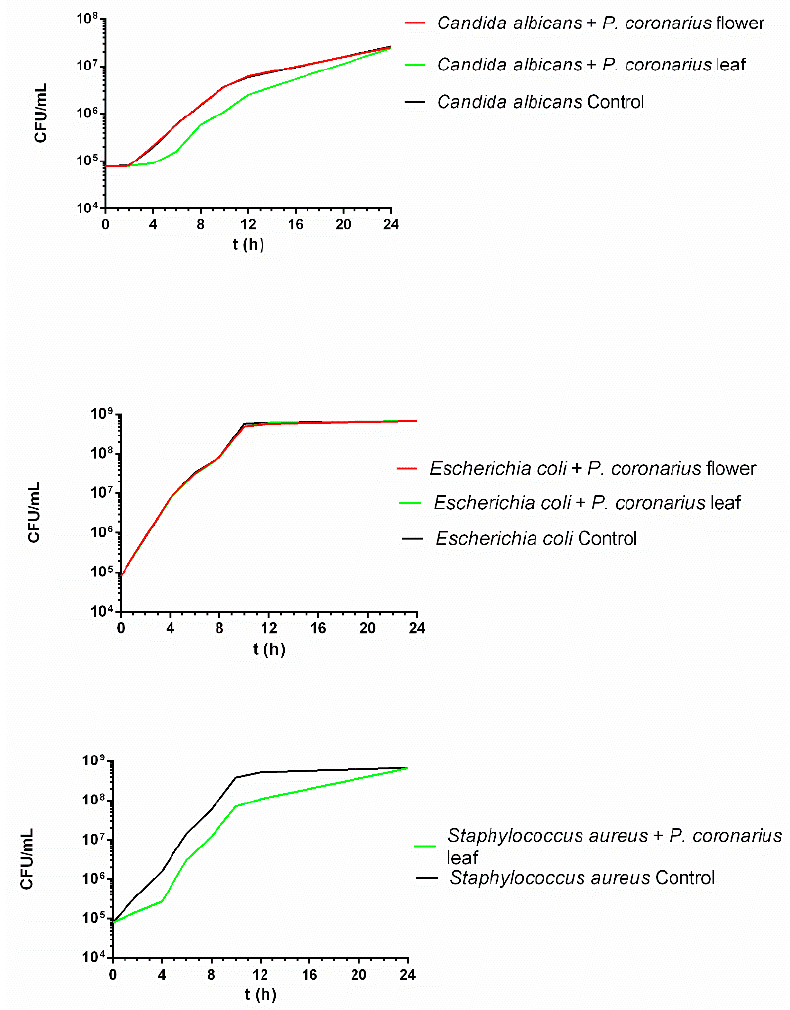
Figure 2. In vitro time-kill test of P. coronarius flower and leaf. The flower was not able to inhibit or delay the growth of bacteria or fungi, but the leaf was able to delay the growth of C. albicans and S. aureus compared to the